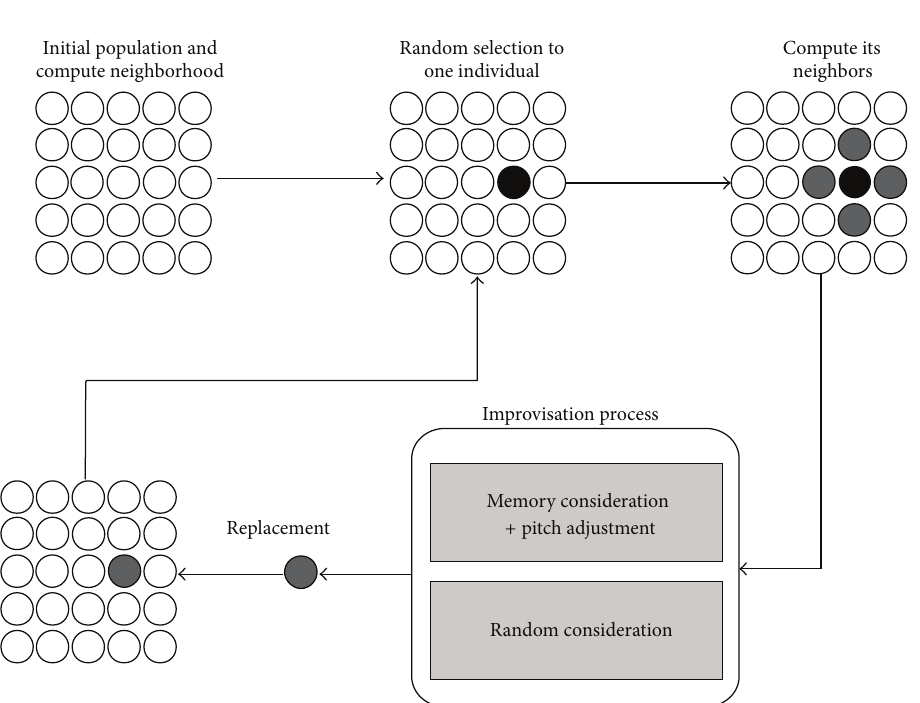
Figure 5: Neighboring shapes [22].